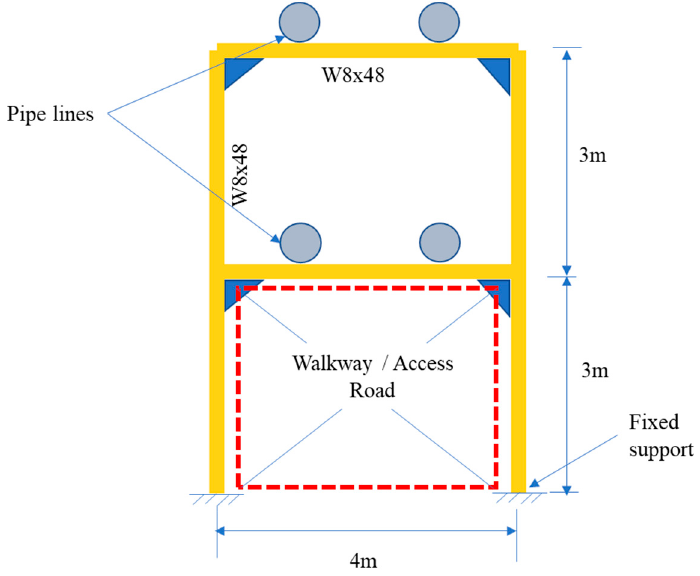
Figure 3. The steel frame model description.